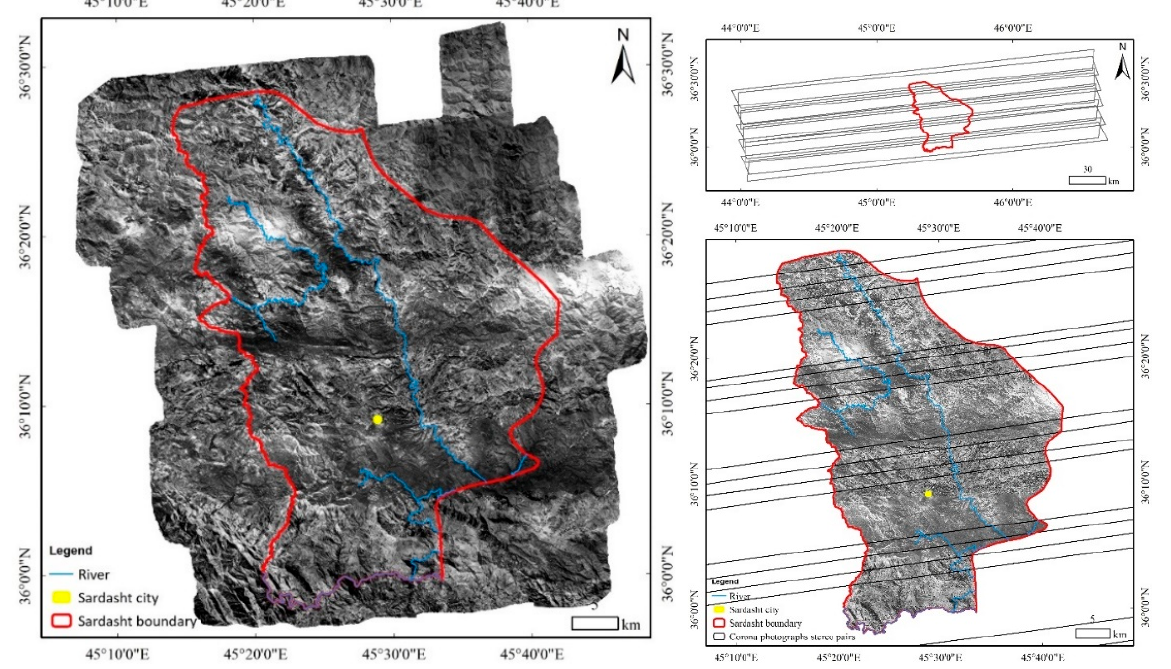
Figure 3. Location of Sardasht region in Corona stereo pairs ( top right ), georeferenced 1955 aerial photo ( left ) and Corona spy satellite photographs mosaic ( bottom right ).